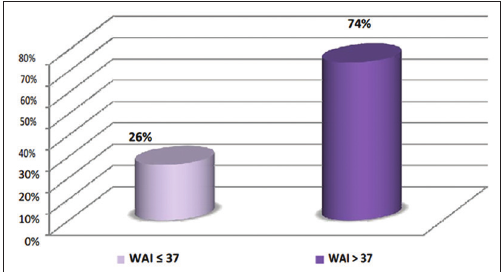
FIGURE 2. Share of the employees with suboptimal (WAI ≤ 37) and optimal (WAI > 37) work ability. Of the total number of the employees in Sarajevo Tobacco Factory, 71 (26%) of them had suboptimal work ability (WAI ≤ 37), while optimal work ability (WAI > 37) was reported by 199 (74%) employees.